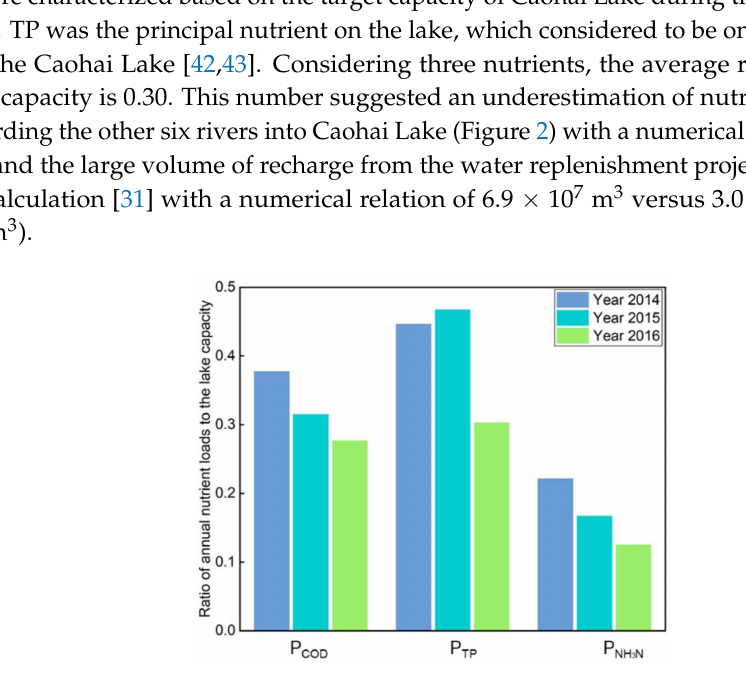
Figure 13. Ratio of annual nutrient load contributions to the lake capacity by